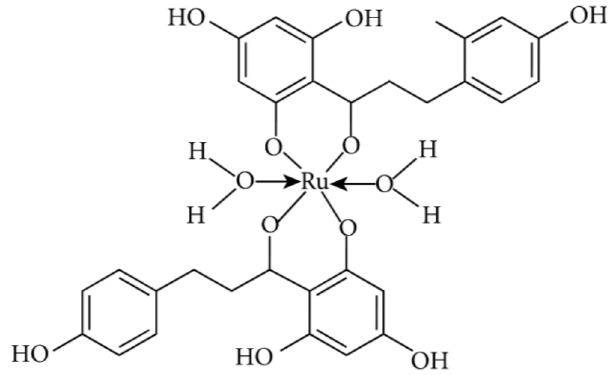
Figure 8. Ruthenium metal complexation of phloretin